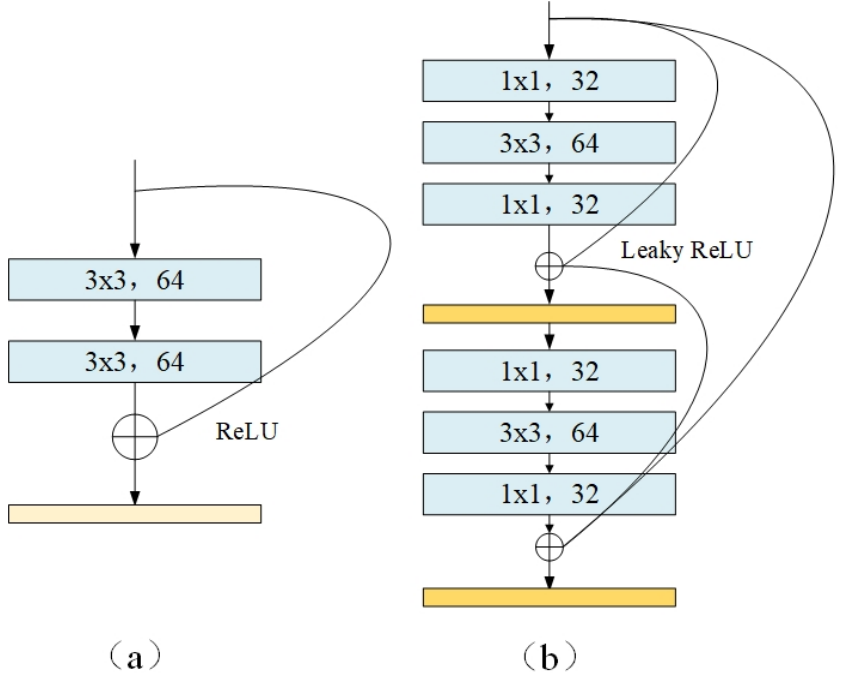
Figure 3. ( a ) Residual structure of ResNet; ( b ) Multiplexing connection residual structure.